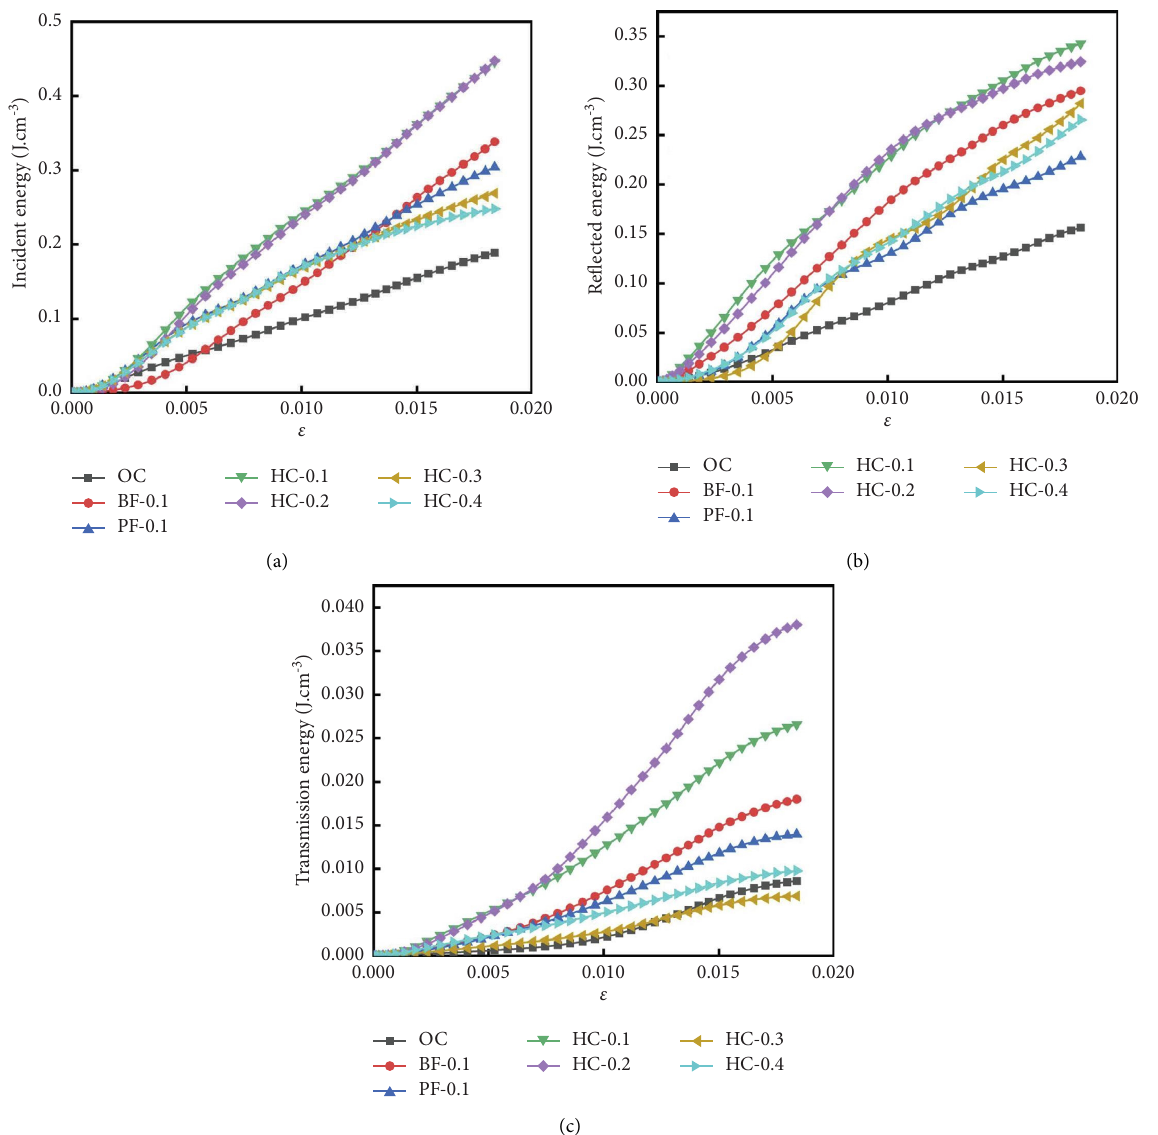
Figure 16: Energy evolution law. (a) Incident energy, (b) Refected energy, (c) Transmission